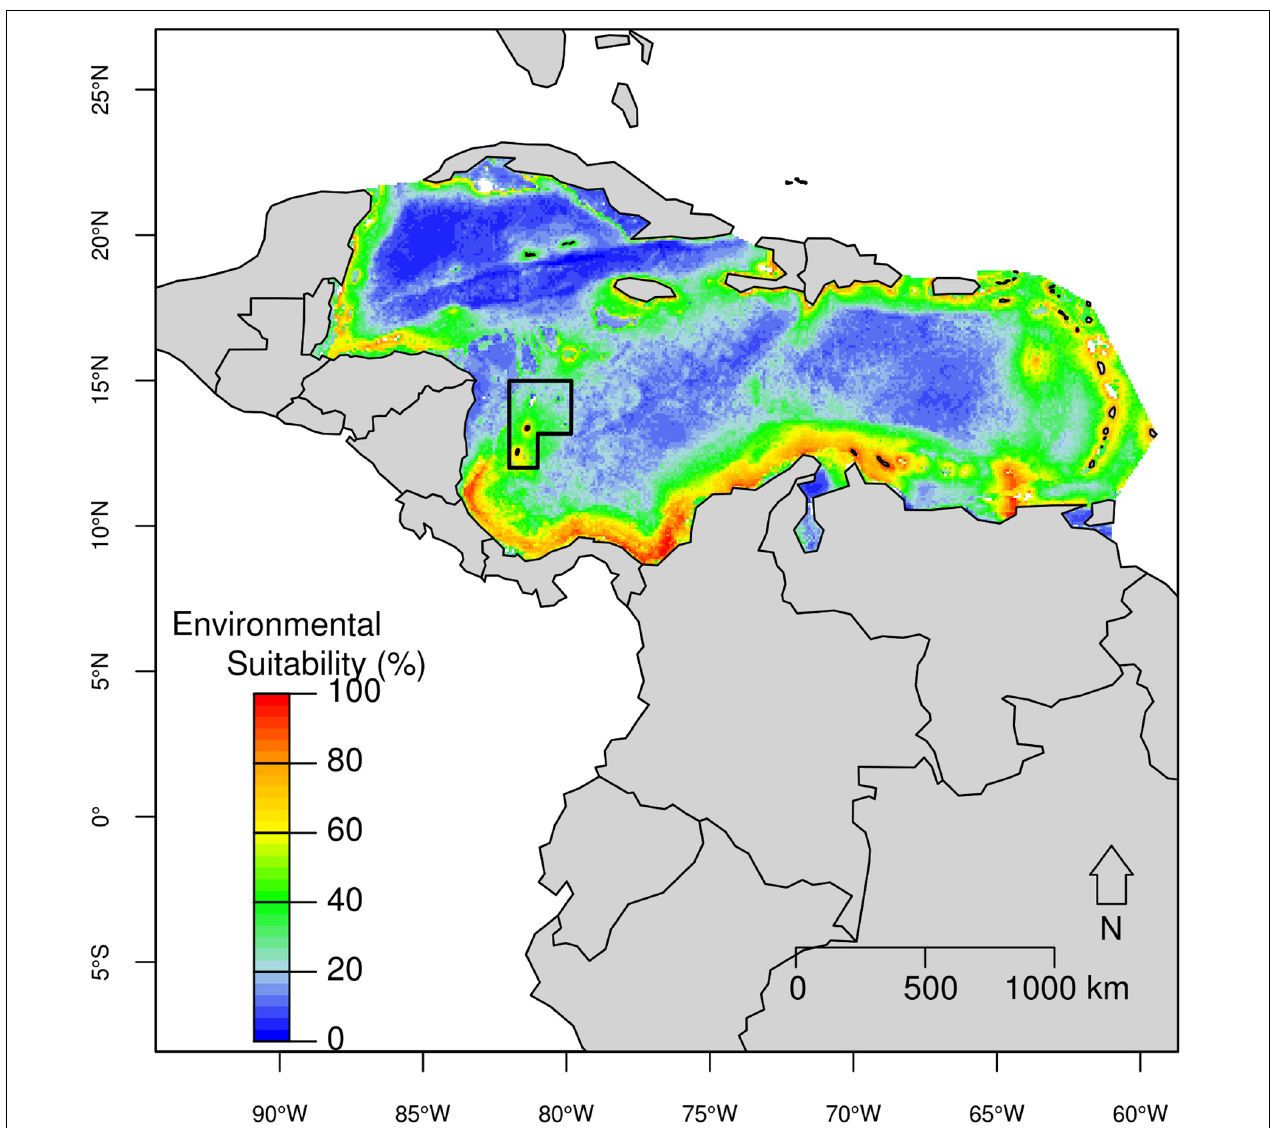
FIGURE 4 | Predicted potential distribution for the pantropical spotted dolphin in the Caribbean Basin from the best ecological niche model. Red colors indicate highest habitat suitability and blue lowest suitability.